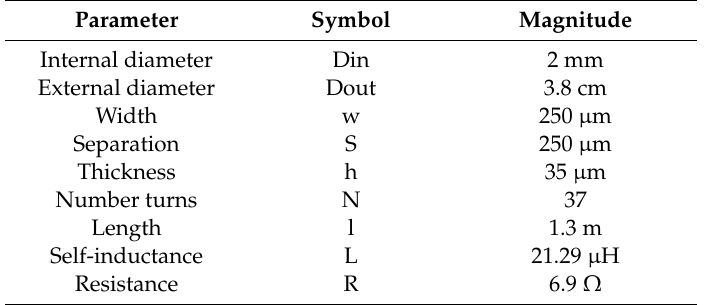
Table 3. Printed circuit board (PCB) parameters for the fabricated internal